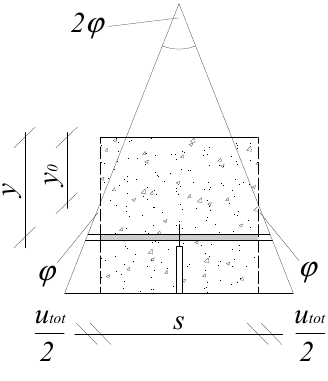
Figure 4. Strain at notch section and deformation of a generic strip of the hinge.